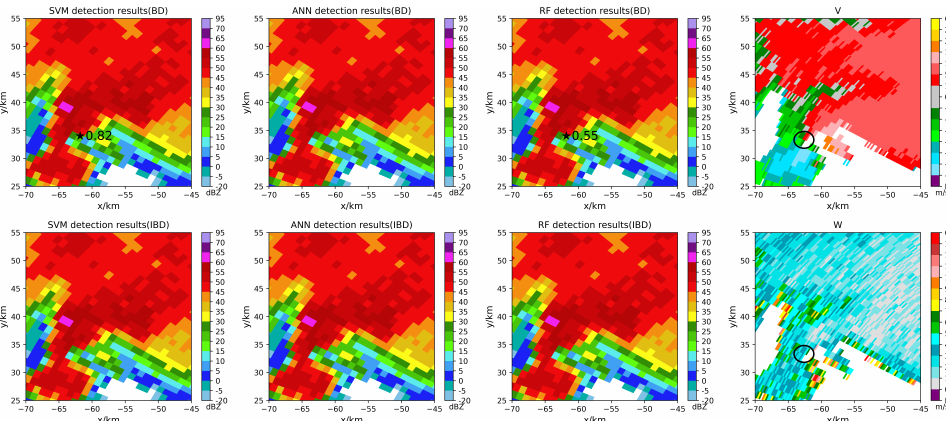
Figure 7. The results of models early warning the tornado at 14:08 (Beijing time, UTC+8) 1.5-degree (the black circle centered at the models warning results with a radius of 1.5 km, the SVM, ANN, RF represent Support Vector Classifier, Artificial Neural Network Classifier, Random Forest Classifier, the V represents Doppler Velocity, and the W represents Doppler Velocity Spectral Width. The BD indicates that the classifier was formed on a balanced tornado dataset, and the IBD indicates that the classifier was formed on an imbalanced tornado dataset.).